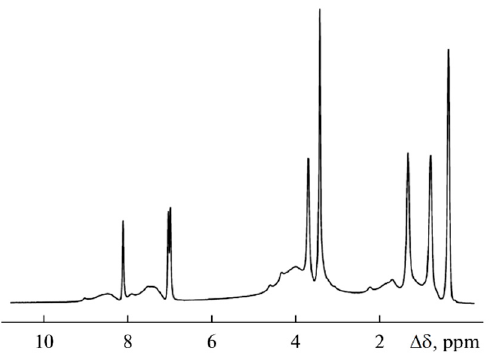
Figure 22. 1 H NMR spectra of sample 3 [58].